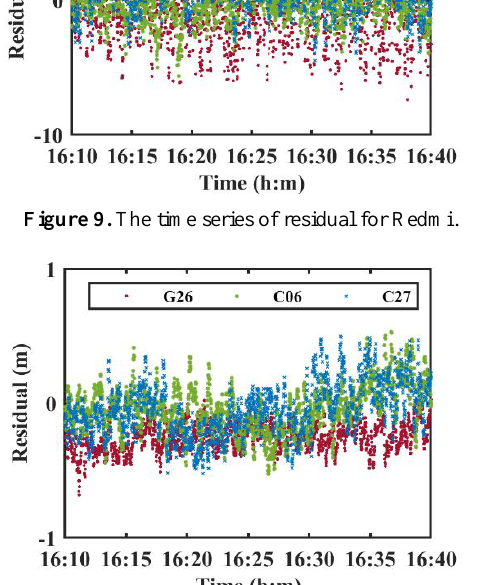
Figure 10. The time series of residual for